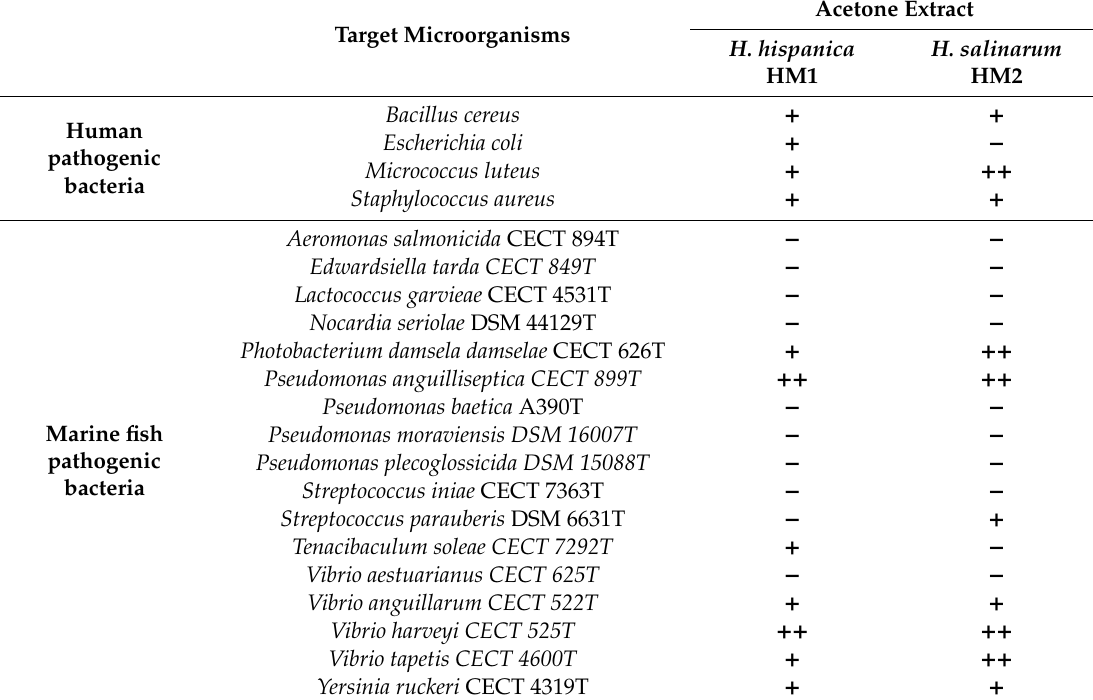
Table 1. Antimicrobial activity of acetone